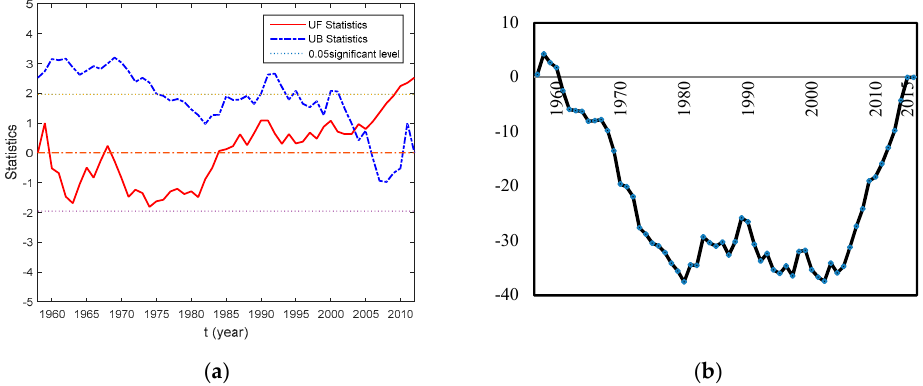
Figure 5. ( a ) Change trends of the M-K test; ( b ) Cumulative anomaly of the annual runoff in Yingluoxia station.